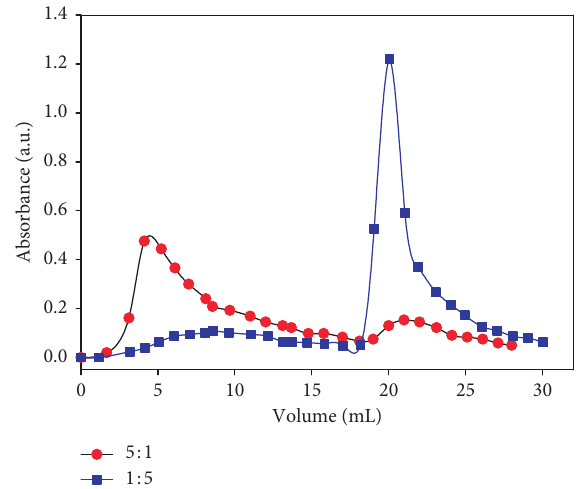
Figure 4: Elution curves of a mixture of TAR and SY in the ratio of 5 :1 (20 and 100 μ g) and 1 :5. Eluent: 2mmol · L − 1 KH 2 PO 4 (pH 3) containing 2.5% acetonitrile with step increase to 10% after